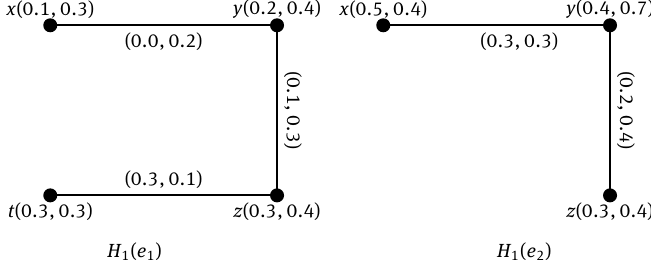
Figure 2: Interval-valued fuzzy soft graph (cid:102) G 1